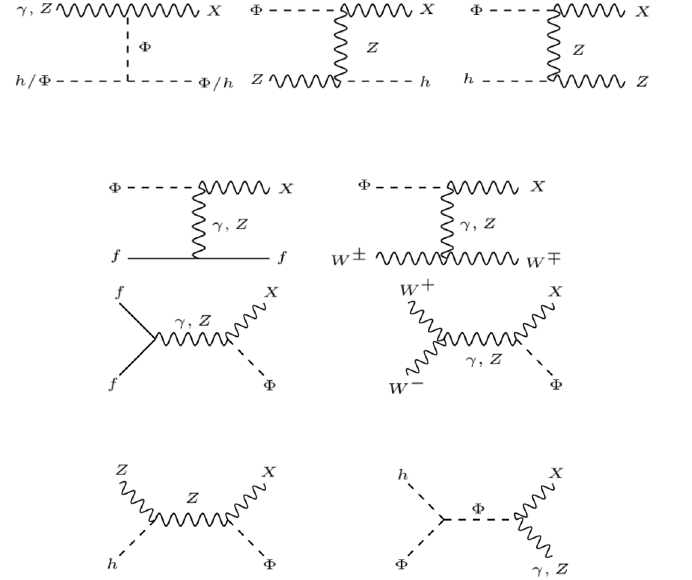
Figure 4 . Annihilations via t -channel (left panel) and s -channel (right panel) leading to the production of X after